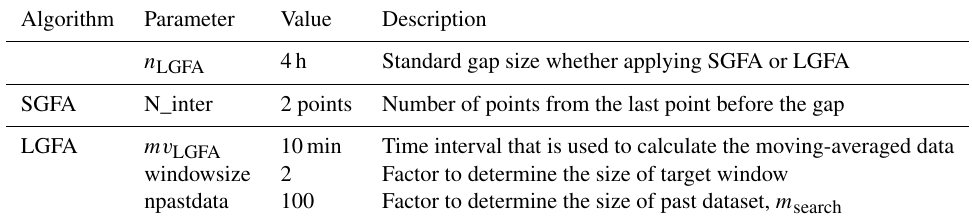
Table 2. Parameters of a gap-filling algorithm. Algorithm